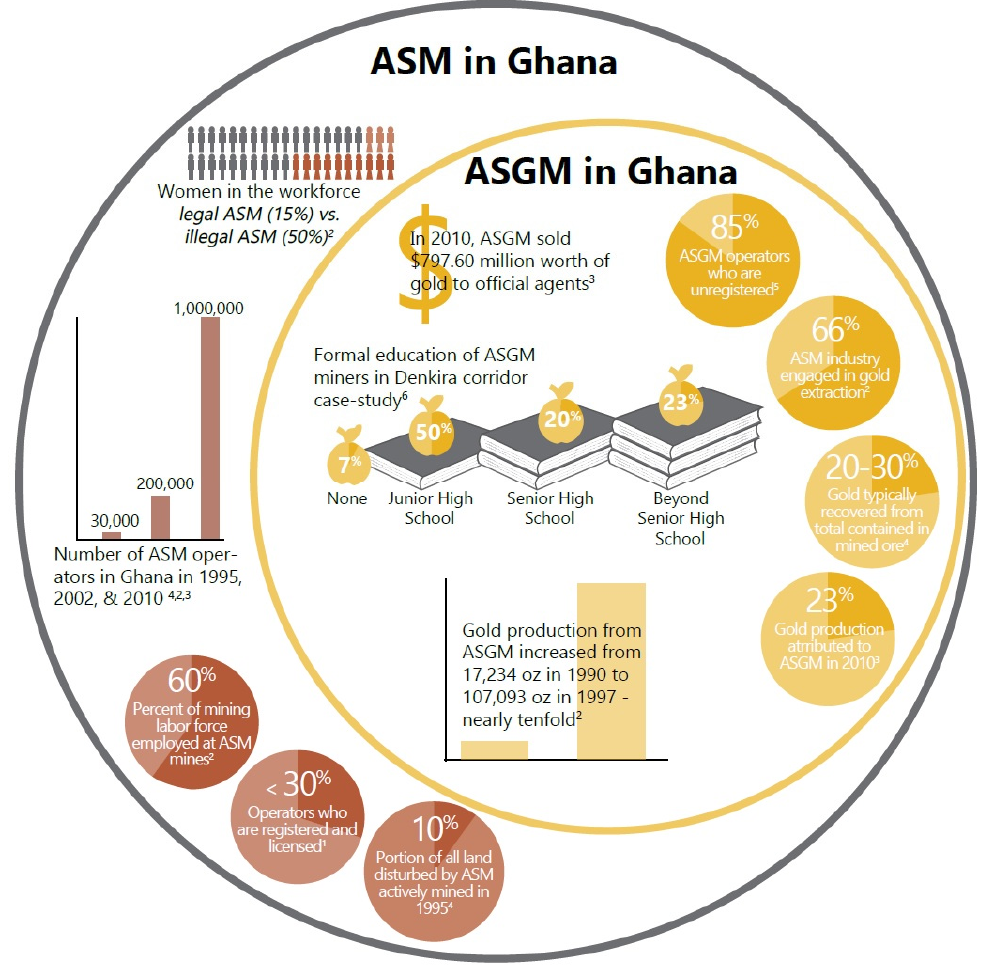
Figure 1. Graphic of estimated statistics available on ASM (artisanal and small-scale mining) and ASGM (artisanal and small-scale gold mining) in Ghana.